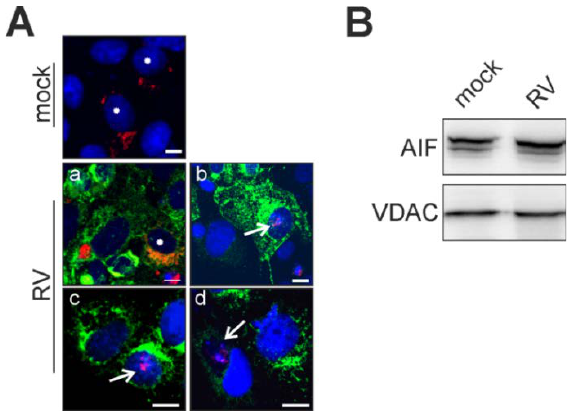
Figure 3. Release of the mitochondrial death-effector protein AIF. Vero cells overexpressing AIF-TagRFP were applied at 2 dpi ( A ) for determination of RV-induced translocation of AIF-TagRFP (shown in red) from mitochondria to the nucleus. Nuclear DNA is shown in blue, the viral E1 protein is shown in green. Asterisks (mock and Aa) indicate physiological localization of AIF to mitochondria. Arrows (Ab,c and d) highlight cells with nuclear association of AIF; ( B ) 30 μg of mitochondrial fractions obtained at 3 dpi from mock- and RV-infected Vero cells were subjected to Western blot analysis with anti-AIF antibody. As a loading control, anti-VDAC antibody was applied. Scale bar, 10 μm.